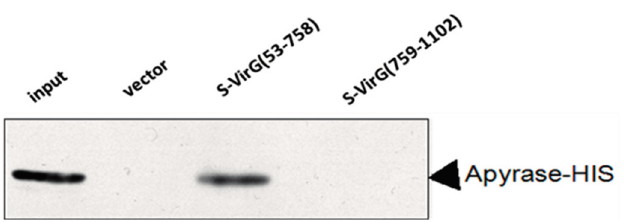
Figure 6. Apyrase protein could bind to the α -domain of VirG protein